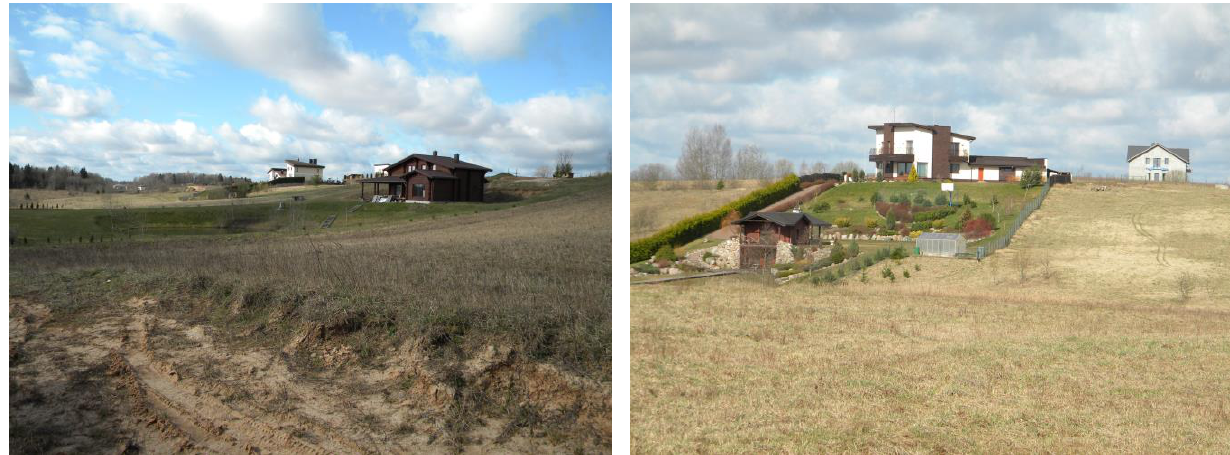
Fig. 8. Suburban dwellings sparsely distributed in agricultural land (Source: